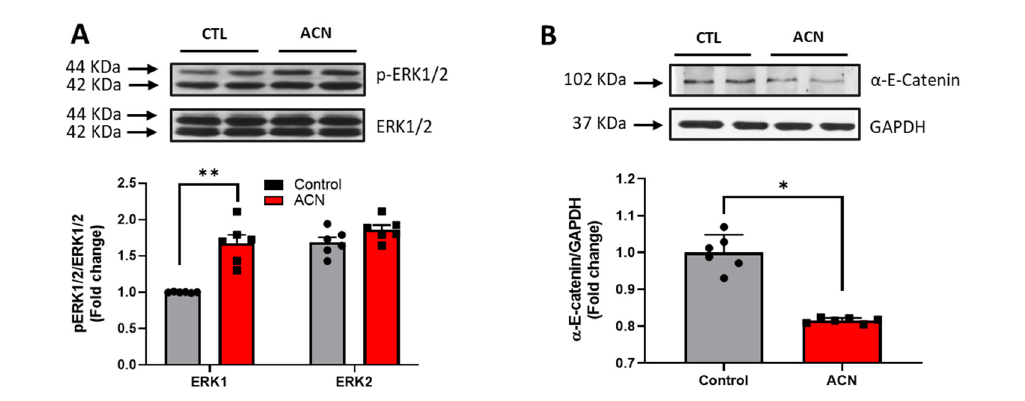
Figure 2. Volcano plot of differentially regulated proteins identified by protein array: under-expressed proteins are shown in green, overexpressed proteins are shown in red and proteins verified by Western blot analyses are shown in blue.